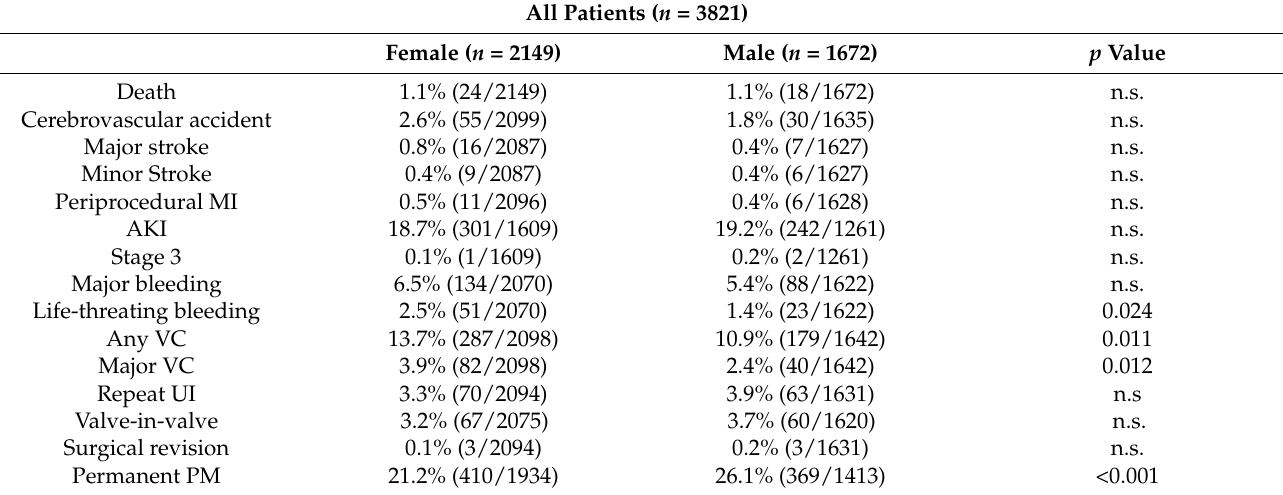
Table 2. Peri-procedural complications.